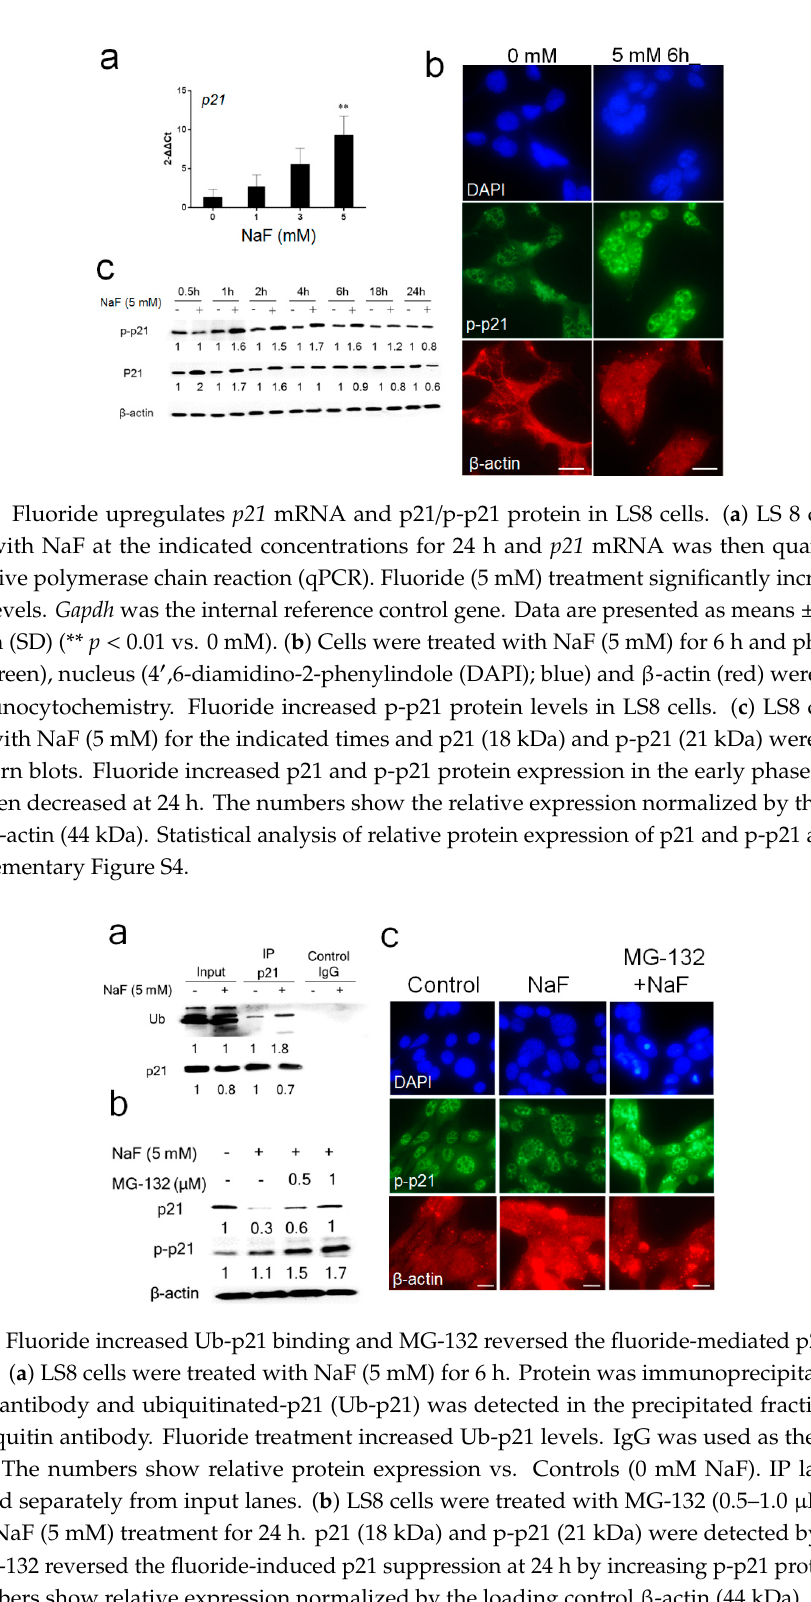
Figure 1. Fluoride upregulates p21 mRNA and p21/p-p21 protein in LS8 cells. ( a ) LS 8 cells were treated with NaF at the indicated concentrations for 24 h and p21 mRNA was then quantified by quantitative polymerase chain reaction (qPCR). Fluoride (5 mM) treatment significantly increased p21 mRNA levels. Gapdh was the internal reference control gene. Data are presented as means ± standard deviation (SD) (** p < 0.01 vs. 0 mM). ( b ) Cells were treated with NaF (5 mM) for 6 h and phospo-p21 (p-p21; green), nucleus (4',6-diamidino-2-phenylindole (DAPI); blue) and β -actin (red) were detected